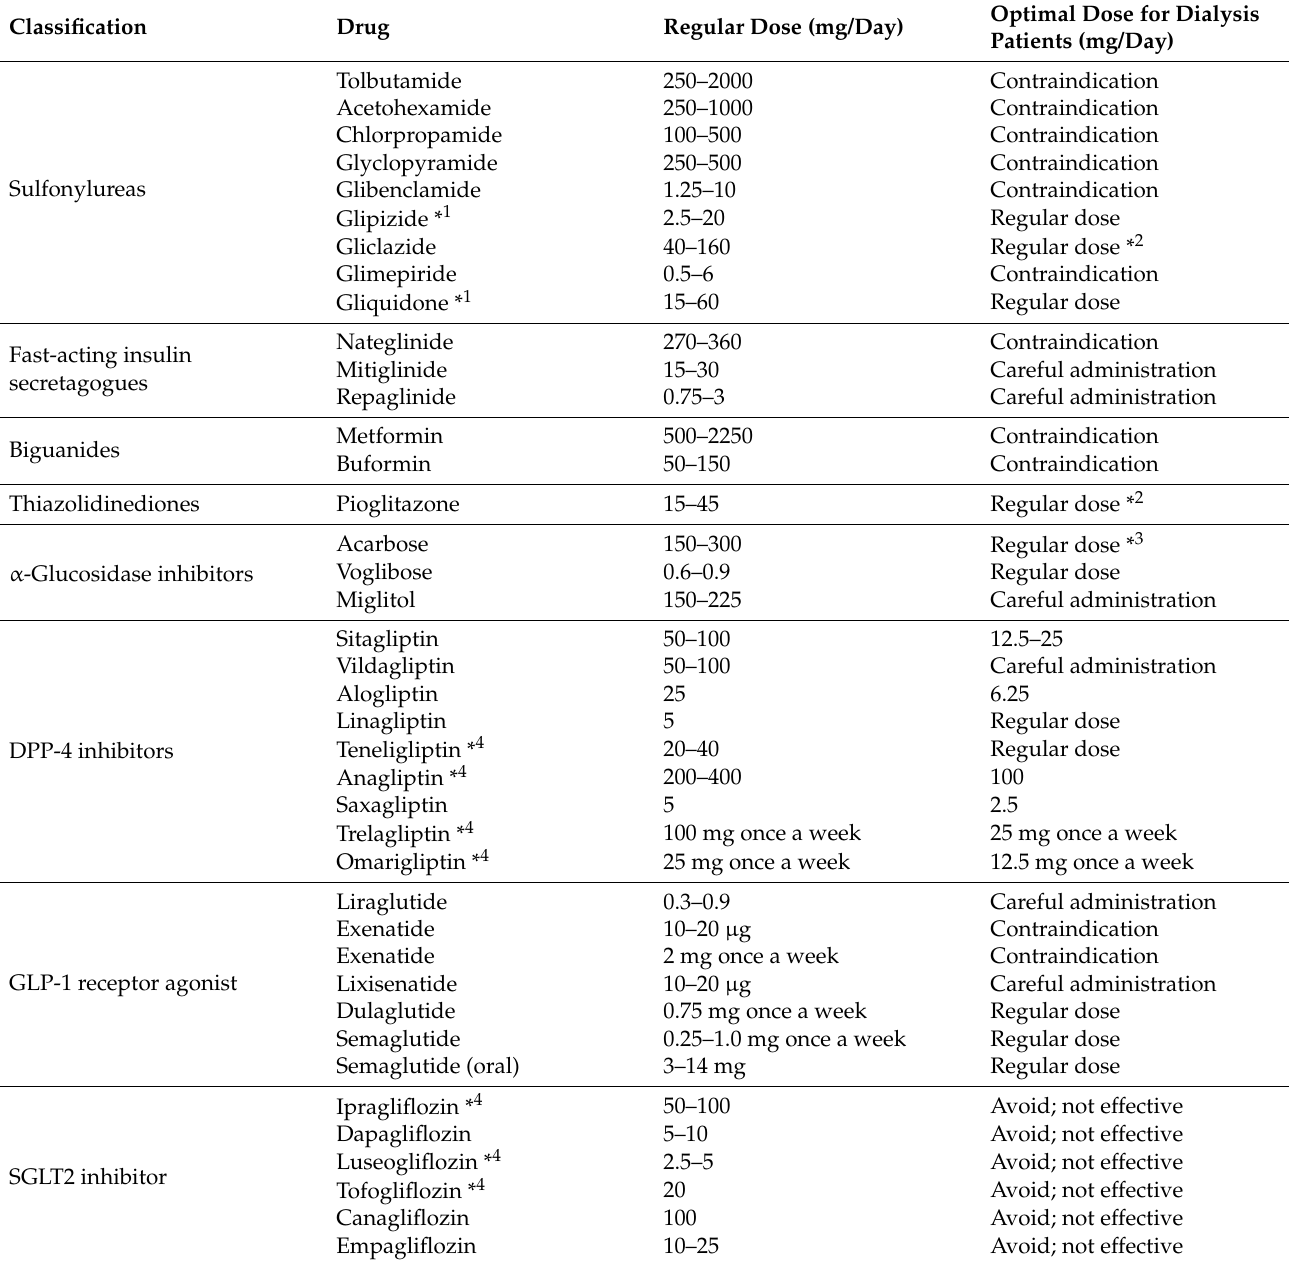
Table 2. Dose recommendation in diabetes patients on